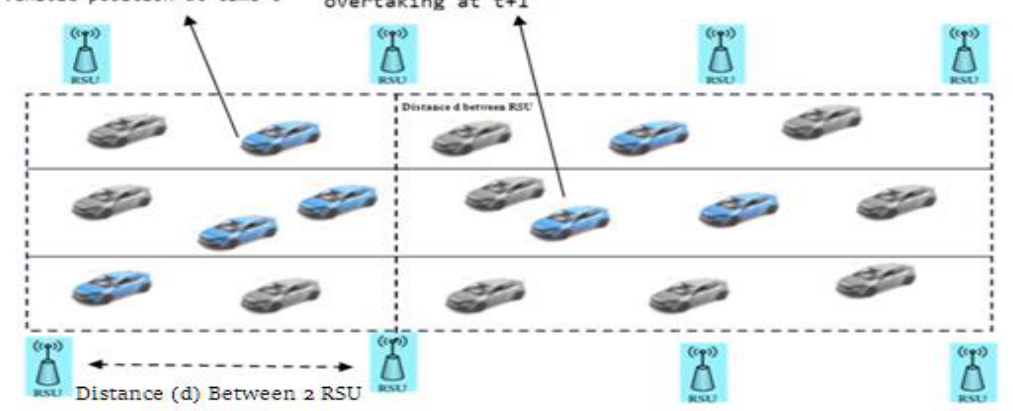
Figure 7. System Design of proposed